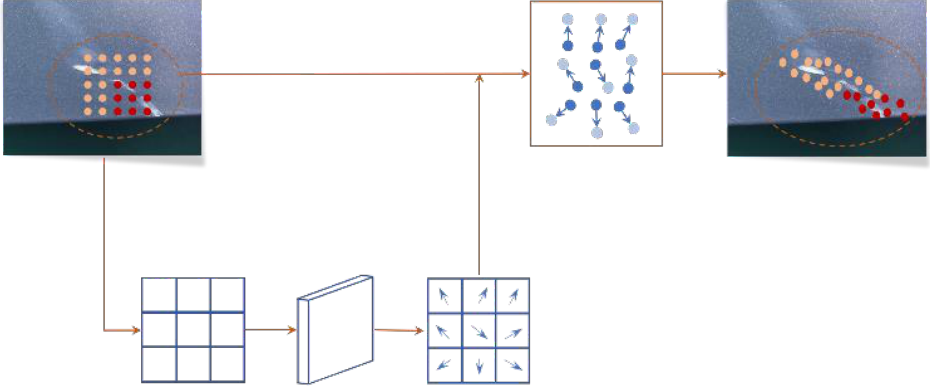
Figure 5. Comparison of feature point receptive fields of conventional convolution and deformable convolution.